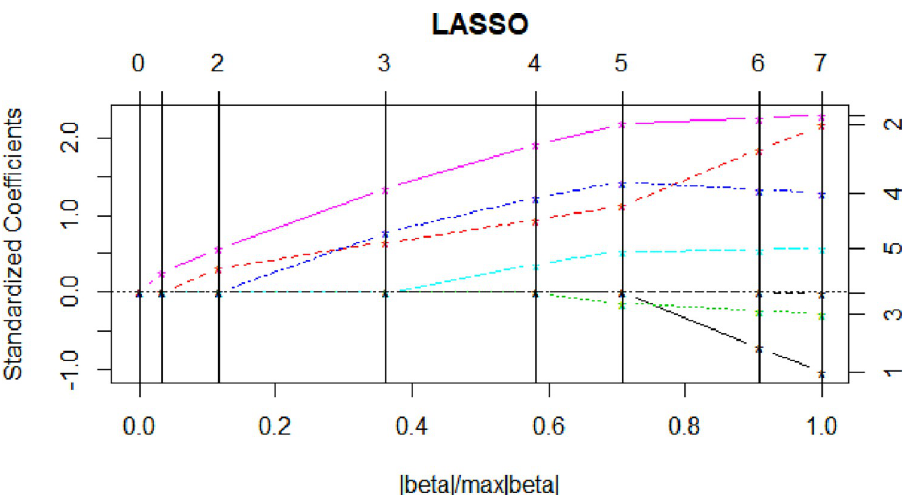
Fig 3. Components variation of the coefficient vector within the industry scope.